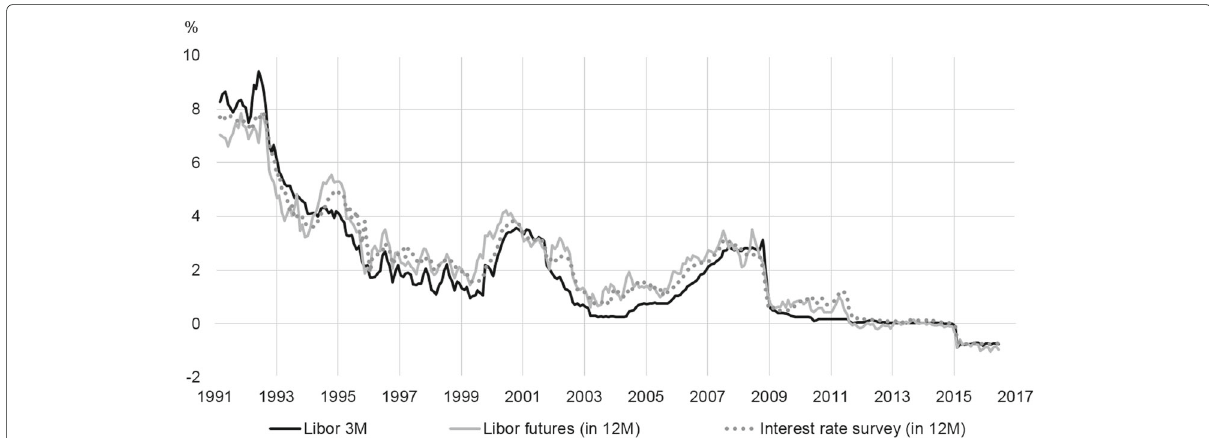
Fig. 1 Interest rate developments. The figure shows the development of the CHF 3-month LIBOR fixing (black line), the interest rate survey with an end of month maturity in 12 months (gray dotted line), and LIBOR futures with an end of month maturity in 12 months (gray line). The dataset contains monthly observations from March 1991 through August